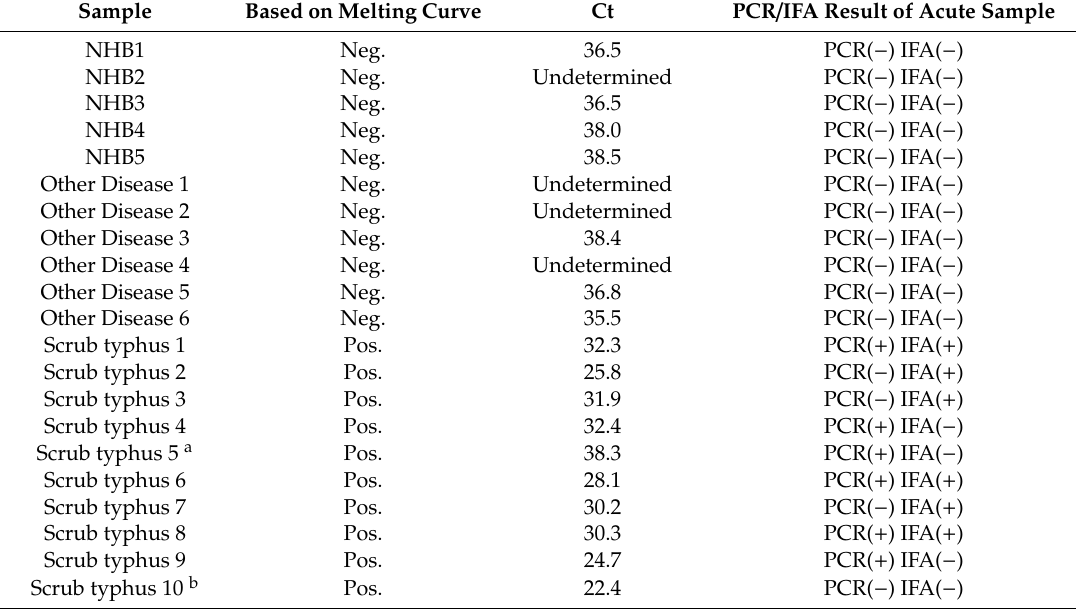
Table 3. Results of traD qPCR using clinical confirmed scrub typhus patient samples *.